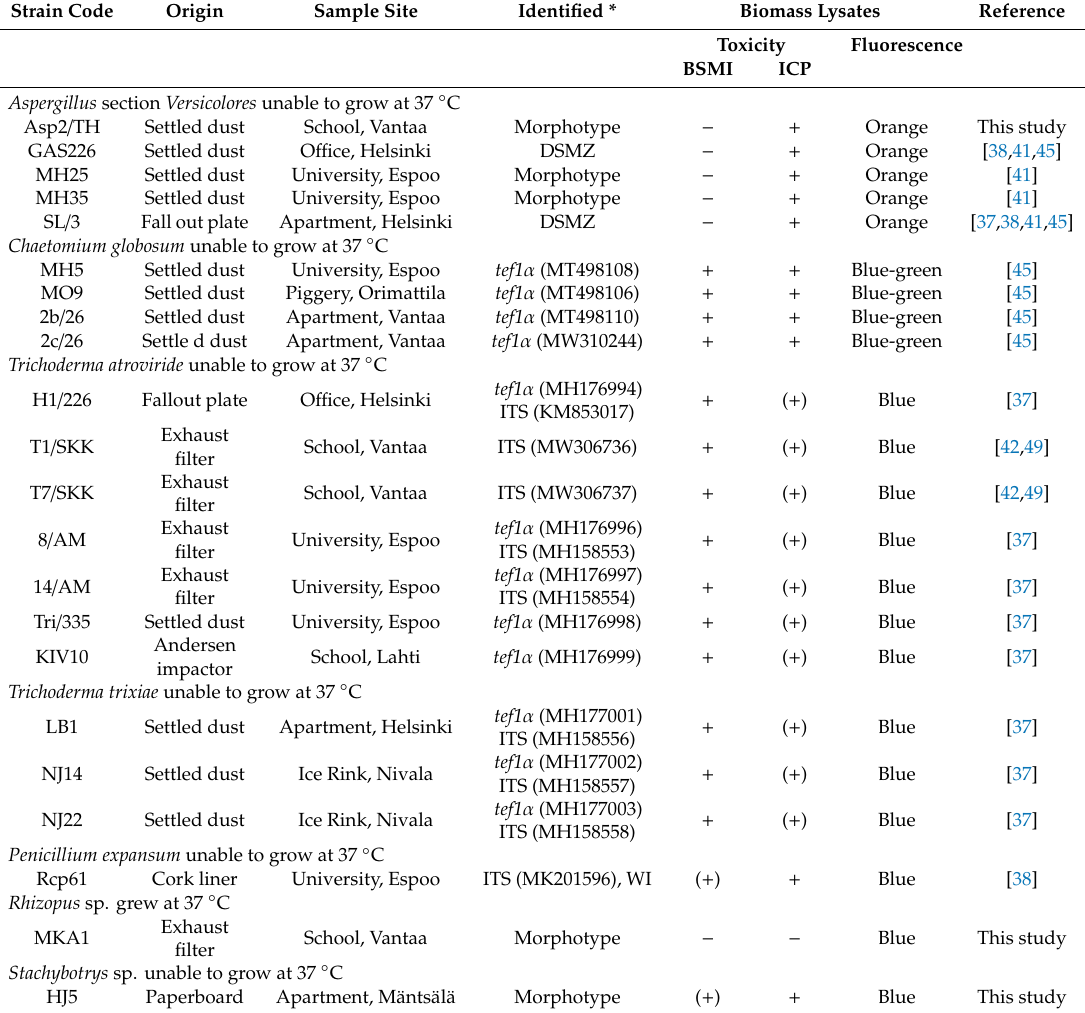
Table 1. Identification and origin of the indoor fungal strains used in this study. The biomass lysate was considered toxic when 2.5 vol % decreased boar sperm motility in the BSMI assay or 5 vol % decreased proliferation of PK-15 cells in the ICP assay by > 50% compared to the sham-exposed